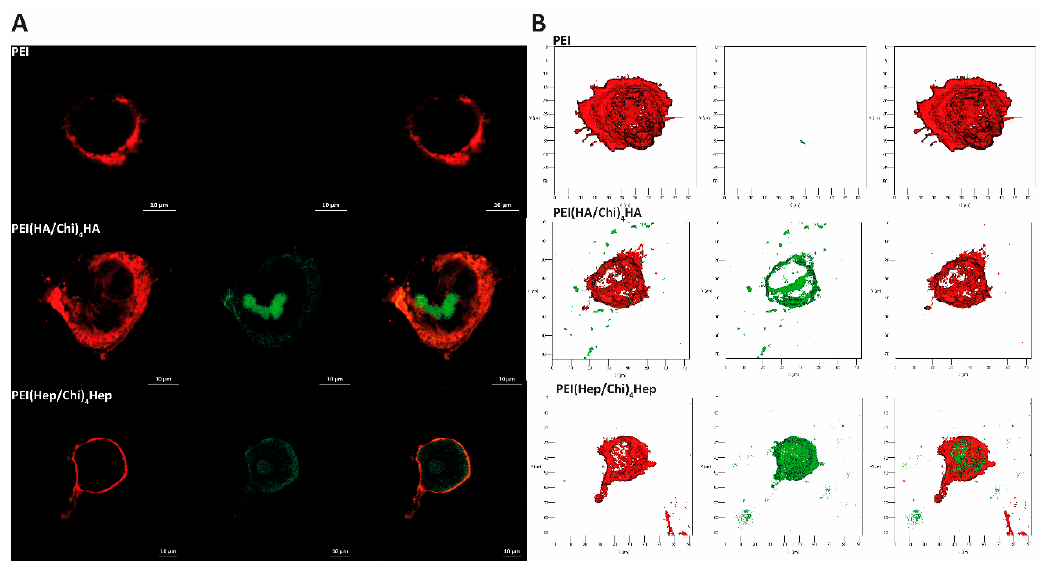
Figure 10. ( A ) Representative confocal laser microscopy (CLSM) images of adherent macrophages stained with the membrane stain DID (red colour) after 24 h cultivation on poly (ethylene imine) (PEI) and terminal layers of PEMs composed of either hyaluronic acid (HA) or heparin (Hep) as polyanions (stained with FITC, green colour) and chitosan (Chi) as a polycation abbreviated as (PEI(HA / Chi) 4 HA, PEI(Hep / Chi) 4 Hep), respectively (63-fold oil immersion objective, Scale bar: 10 µ m). ( B ) Representative 3D view of a z-stacks in surface projection with CLSM (63-fold oil immersion objective, scale: 20 μ m). In this mode, pixel values are computed as solids, which allows no transparency.